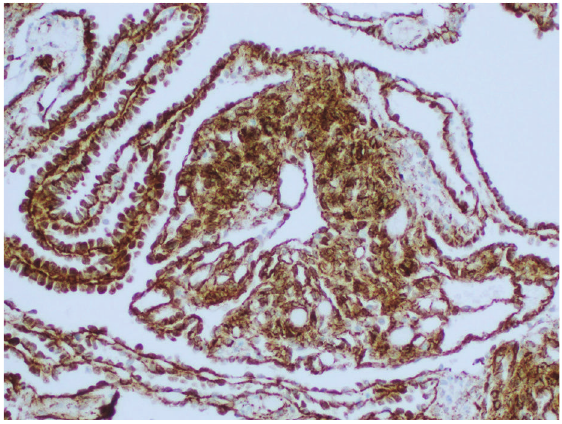
Figure 8: Beta-catenin with nuclear and cytoplasmic positivity in retiform areas